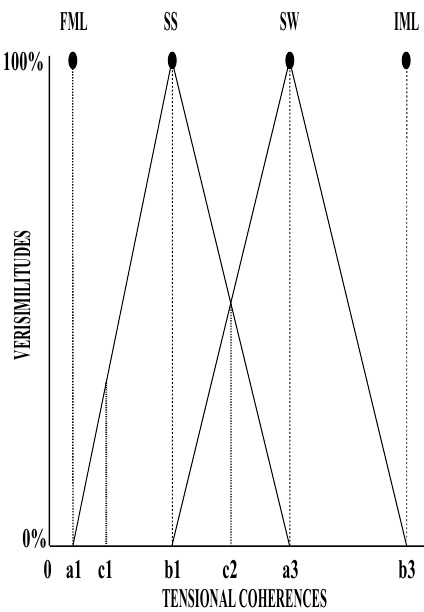
Figure 24. SS and SW as vague